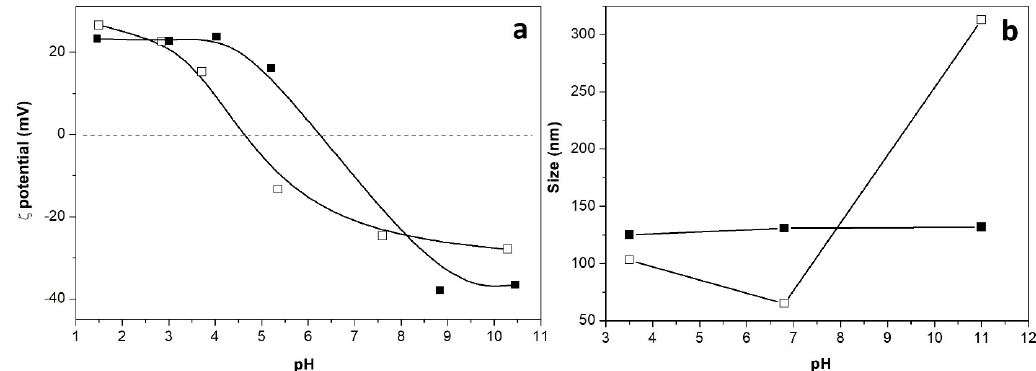
Figure 3. ( a ) ζ − potential curves (reproduced from [25] by kind permission of John Wiley and Sons) and ( b ) size of the particles in the solution based on dynamic light scattering (DLS) behavior at different pH. P25 shown as full squares, FSP as hollow squares.